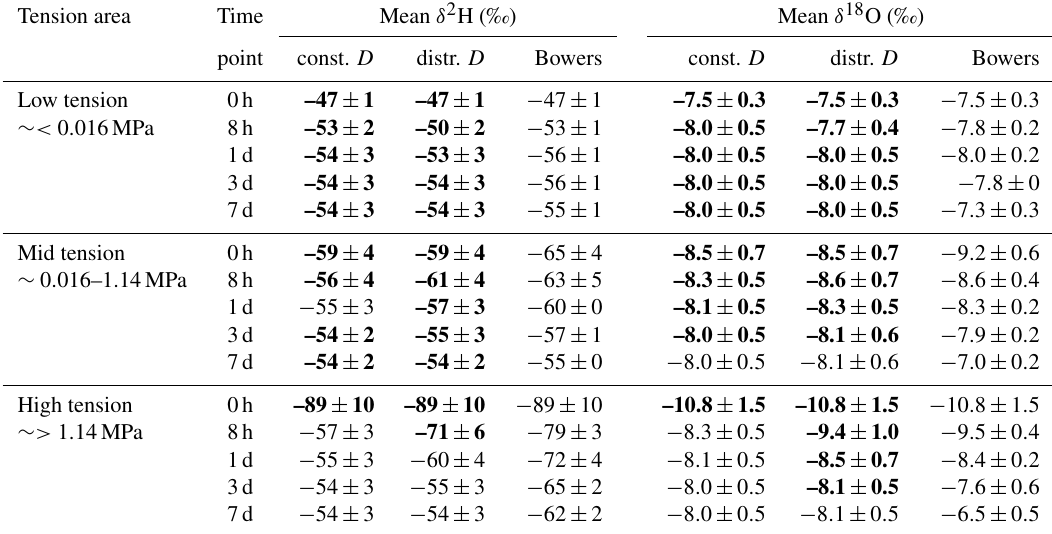
Table 2. Mean and standard deviation of isotopic concentrations in each tension area and time point for simulation with constant (const.) and pore-size-distributed (distr.) D values, respectively. Bold values are within the standard deviation range of the measured values of Bowers et al.